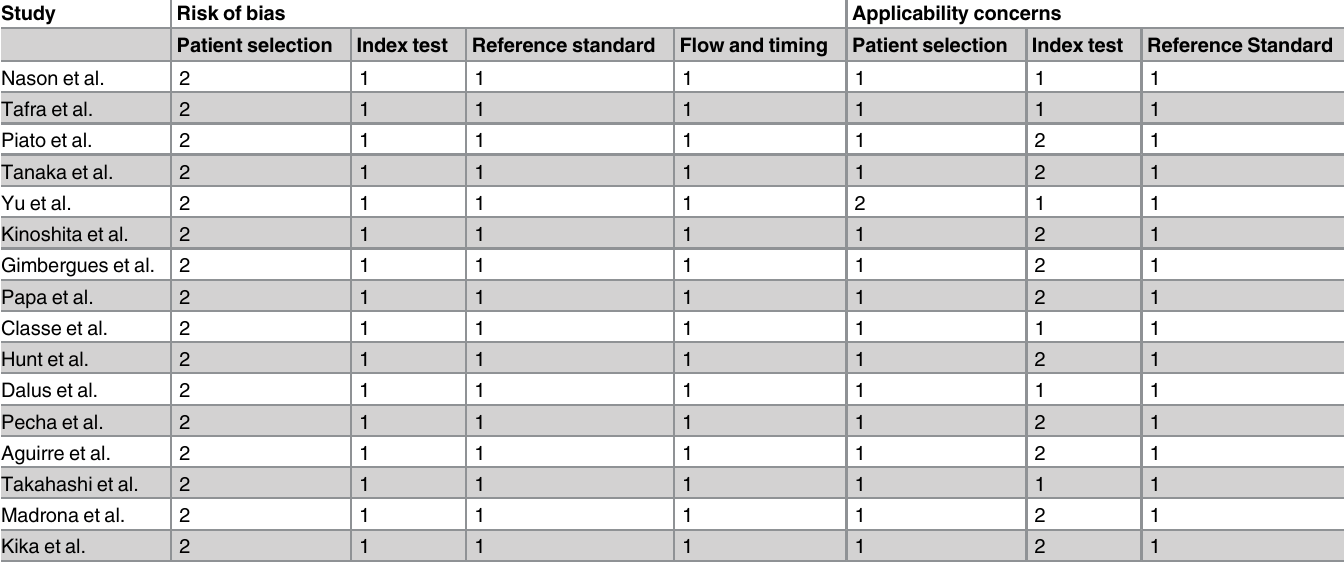
Table 1. Results of quality assessment according to QUADAS 2 for the included